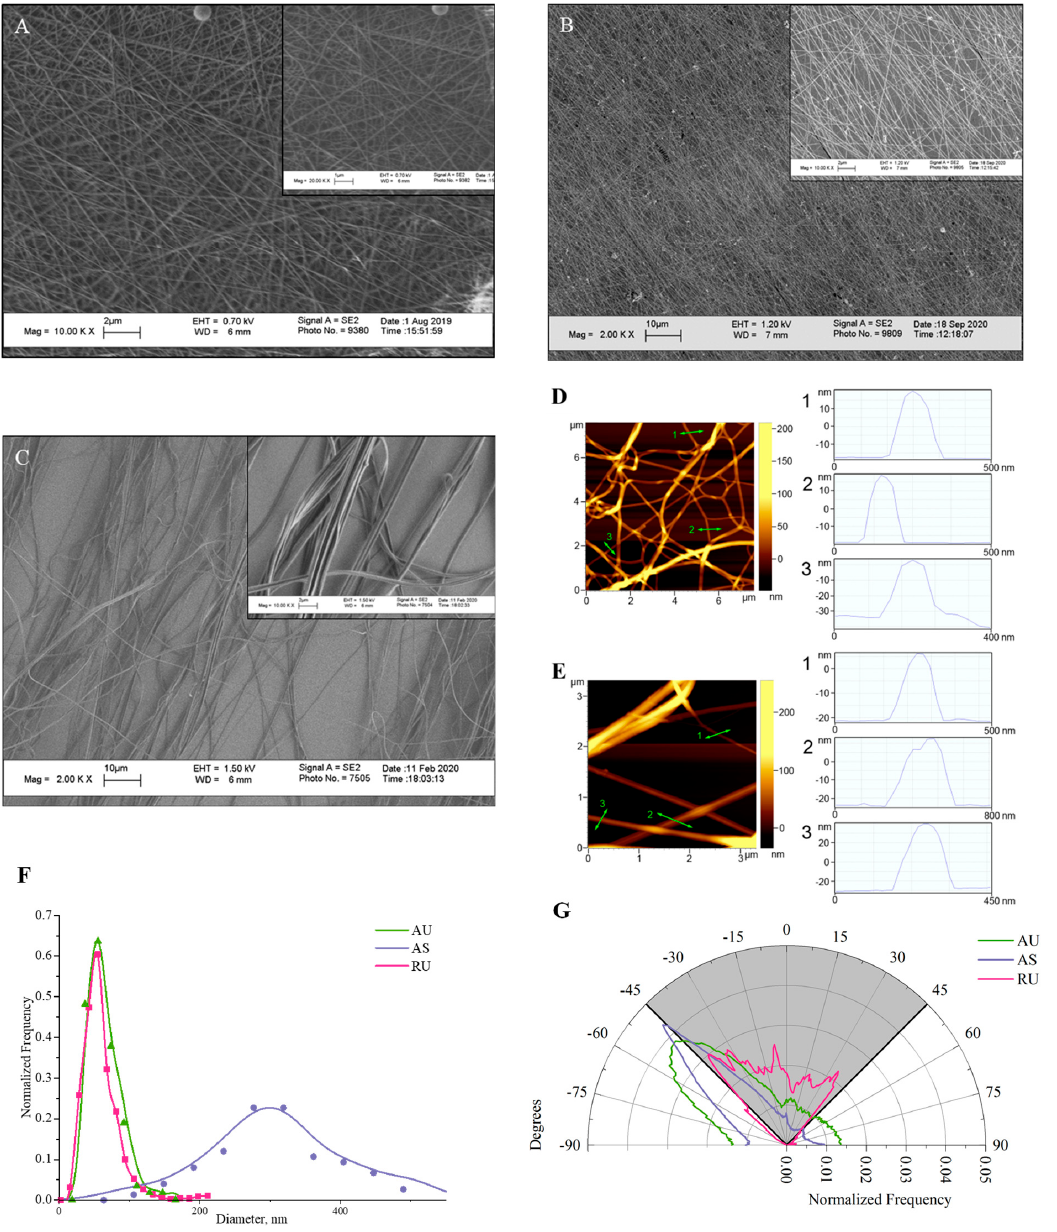
Figure 1. Morphological analysis of nylon nanofibrous scaffolds. SEM images without contrast and histograms of the frequency distribution of the fiber diameter. ( A )—randomly oriented ultrathin fibers (RU); ( B )—aligned ultrathin fibers (AU); ( C )—aligned submicron fibers (AS); ( D , E )—AFM images of RU and AU nanofibers; ( F )—distribution of nanofiber diameters; ( G )—angular distribution of fiber direction.